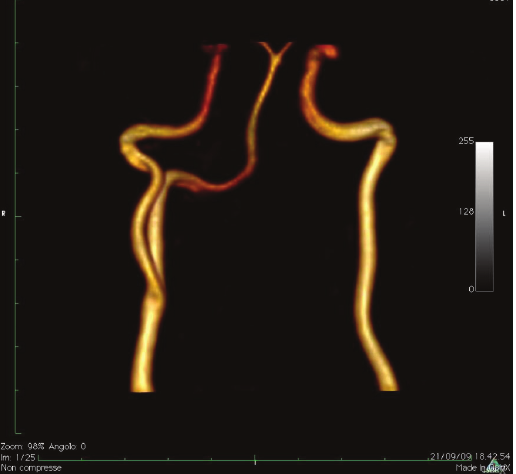
Figure 4: Computed Tomography Angiography (VR reconstruction): the anomalous artery arising from the right internal carotid artery at C2–C3 level joins the basilar